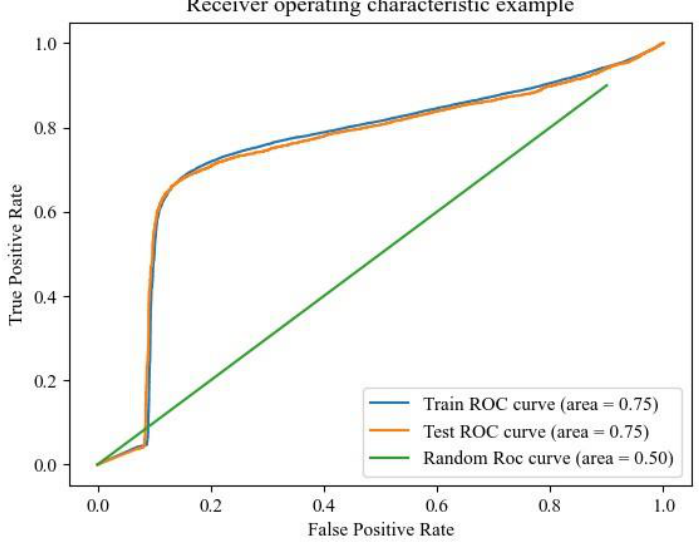
Figure 22. ROC curve of GMM.